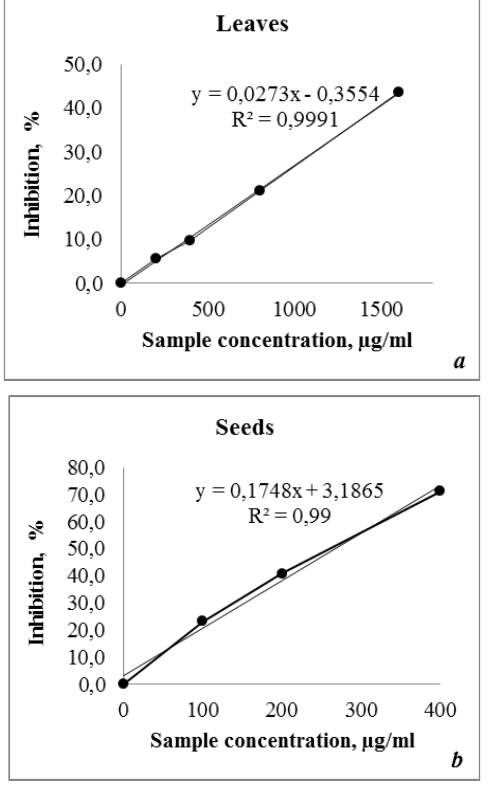
Fig. 2. Linear regration of the leaves (a) and seeds (b) of the methanolic extracts of S.